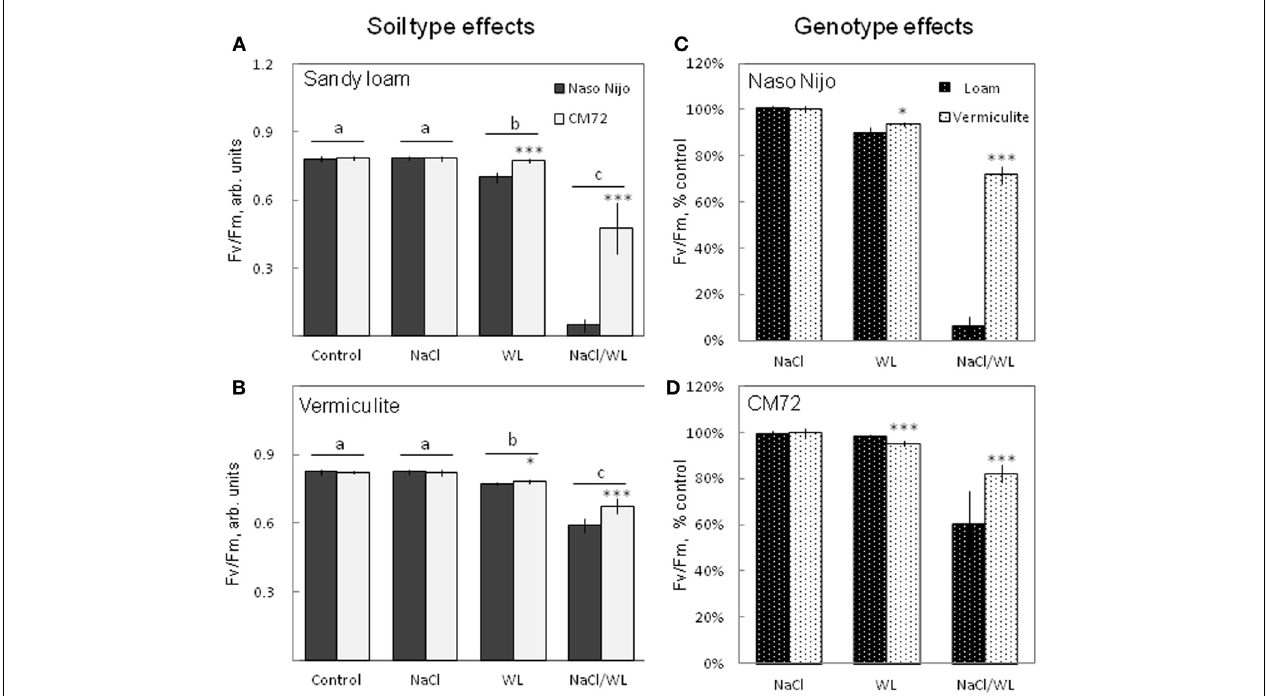
vermiculite. For growth conditions, details of treatments, and media composition, refer to the Materials and Methods section. Mean ± SD ( n = 12). Different lower case letters indicate the significant difference between treatments (averaged for both genotypes) at P < 0 . 01. Asterisks indicate the significant difference between cultivars within the treatment at ∗ P < 0 . 01 and ∗∗∗ P < 0 .